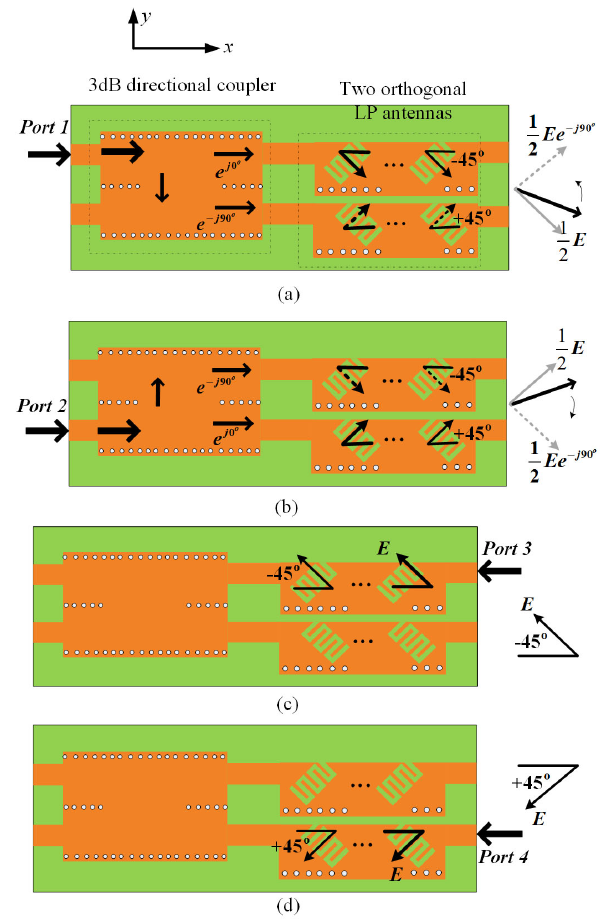
Figure 3. The four excitation and polarization scenarios: ( a ) RHLP (shaded arrows represent the radiation generated by the slot antenna individually), ( b ) LHCP (shaded arrows represent the radiation generated by the slot antenna individually), ( c ) − 45 ◦ LP, and ( d ) +45 ◦